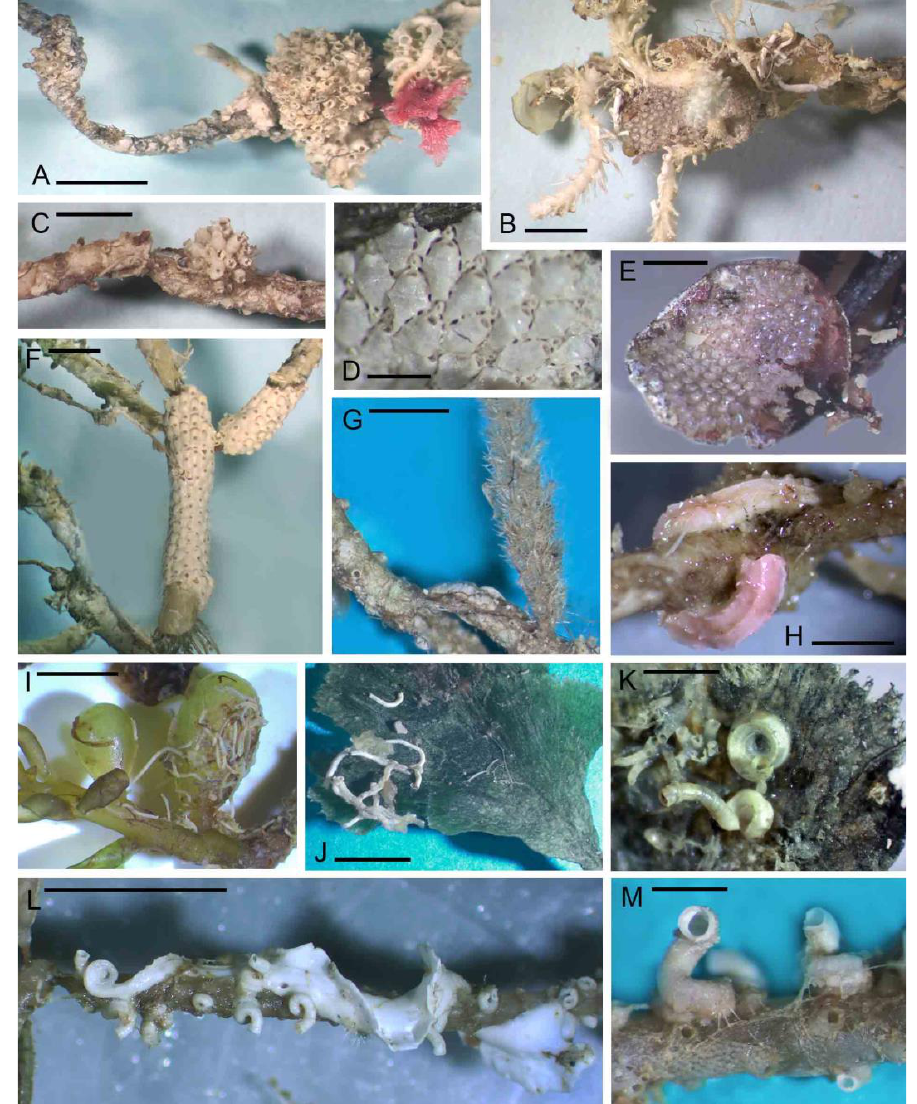
Figure 5. Microscope images of bryozoan and serpulid epibionts on the canopy of the E Build-up collected offshore Marzamemi (Ionian Sea). ( A ): Celleporina caminata and Miniacina miniacea on a Flabellia petiolata stem. PMC. Rosso Collection I. H. B. 98a1. (Scale bar: 2 mm). ( B ) Bryozoans and serpulids clustered on a soft alga PMC Rosso Collection I. H. B. 59b. (Scale bar: 5 mm mm). ( C ) Young Celleporina caminata on Margaretta cereoides , PMC. Rosso Collection I. H. B. 98a2. (Scale bar: 2 mm). ( D ) Chorizopora brongniartii on a fleshy alga. PMC. Rosso Collection I. H. B. 99a1. (Scale bar: 500 μ m). ( E ) Microporella bicollaris on a fleshy alga. PMC. Rosso Collection I.H.B. 96a. (Scale bar: 2 mm). ( F ) Arthropoma cecilii on M. cereoides . PMC. Rosso Collection I. H. B. 100a. (Scale bar: 2 mm). ( G ) Beania cylindrica on M. cereoides . PMC. Rosso Collection I. H. B.101a. (Scale bar: 2 mm). ( H ) Serpula vermicularis on M. cereoides . PMC. Sanfilippo Collection I. H. Pol.-2a. (Scale bar: 2 mm). ( I ) Josephella marenzelleri on Caulerpa cylindracea . PMC. Sanfilippo Collection I. H. Pol-3a. (Scale bar: 2 mm). ( J ) Filograna sp. on Flabellia petiolata . PMC. Sanfilippo Collection I. H. Pol-4a. (Scale bar: 5 mm). ( K ) Neodexiospira pseudocorrugata on F. petiolata . PMC. Sanfilippo Collection I. H. Pol-5a1. (Scale bar: 1 mm). ( L ) Spirobranchus triqueter and several Simplaria pseudomilitaris on M. cereoides . PMC. Sanfilippo Collection I. H. Pol-6a. (Scale bar: 5 mm). ( M ) S. pseudomilitaris on M. cereoides . PMC. Sanfilippo Collection I. H. Pol-7a. (Scale bar: 1 mm).